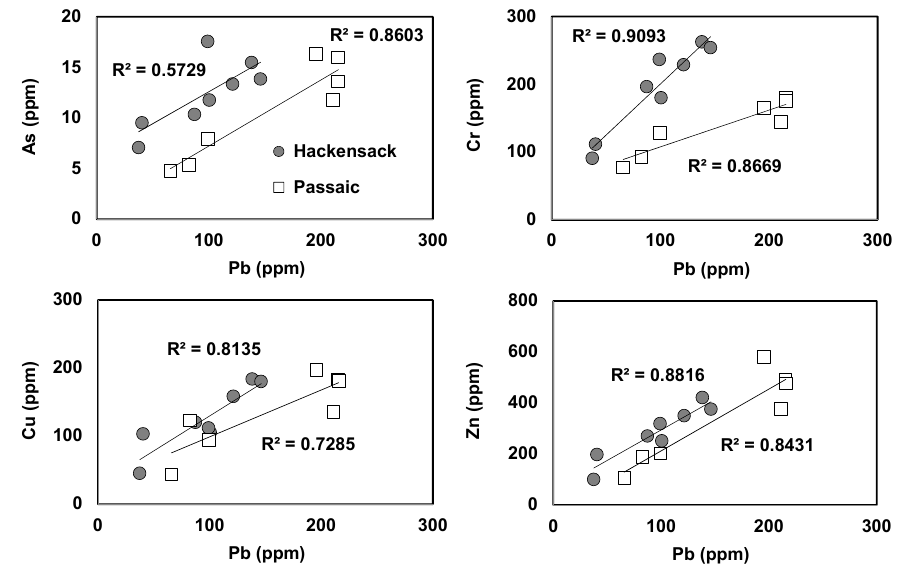
Figure 7. Correlations of heavy metals in sediments (bulk concentration for <2 mm grain size) collected from the Hackensack and Passaic Rivers in summer 2015.